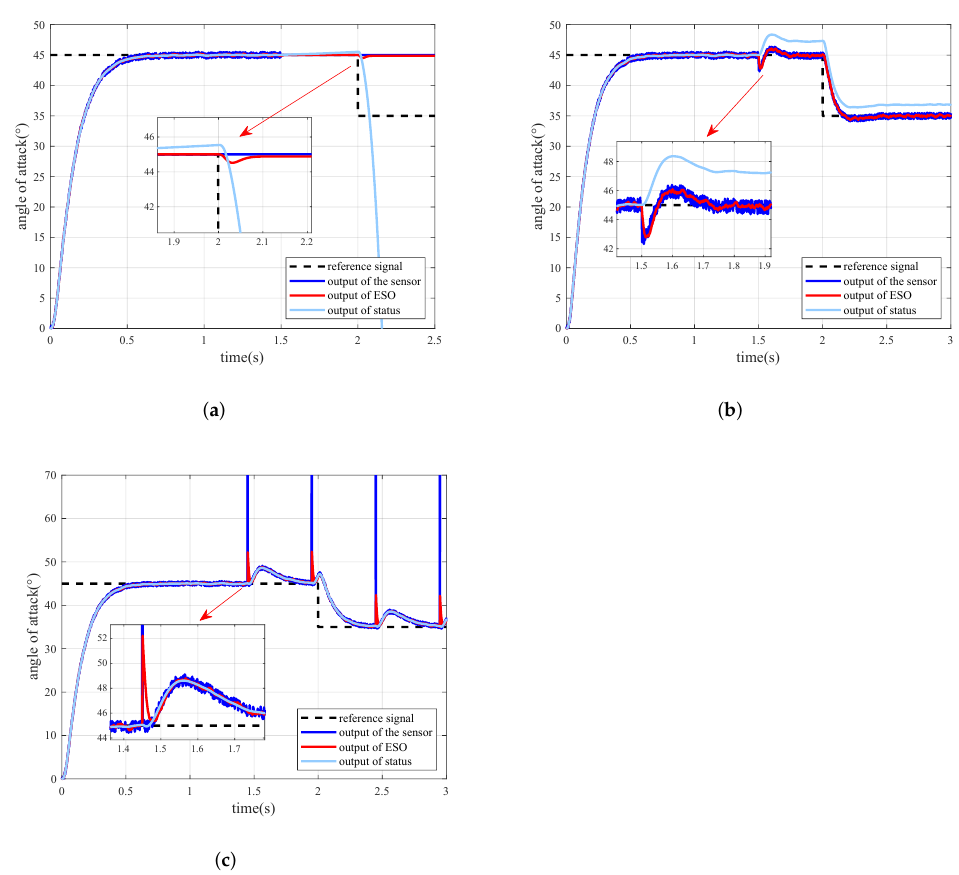
The angle of attack of sensor fault states is compared with that of the fault-free state. The results of the stuck fault, gain variation faults and the outlier data fault are shown in Figure 8a, Figure 8b and Figure 8c, respectively.